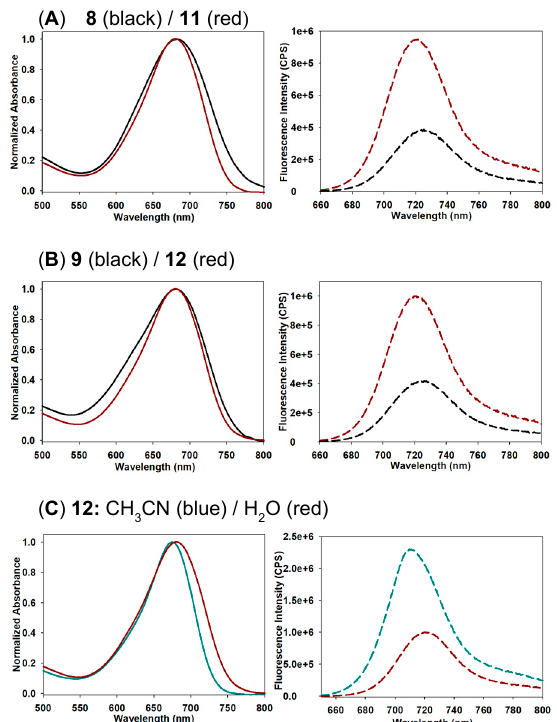
Figure 3. Representative absorption (normalized) and emission spectra of mono- and dual-PEG-substituted fluorophores. (A) Comparison of 8 and 11 in H 2 O (2 µM, 2.5 nm slit widths). (B) Comparison of 9 and 12 in H 2 O (2 µM, 2.5 nm slit widths). (C) Comparison of 12 in H 2 O and CH 3 CN (2 µM, 2.5 nm slit widths). See SI Figure S3 for all absorbance and emission spectra.